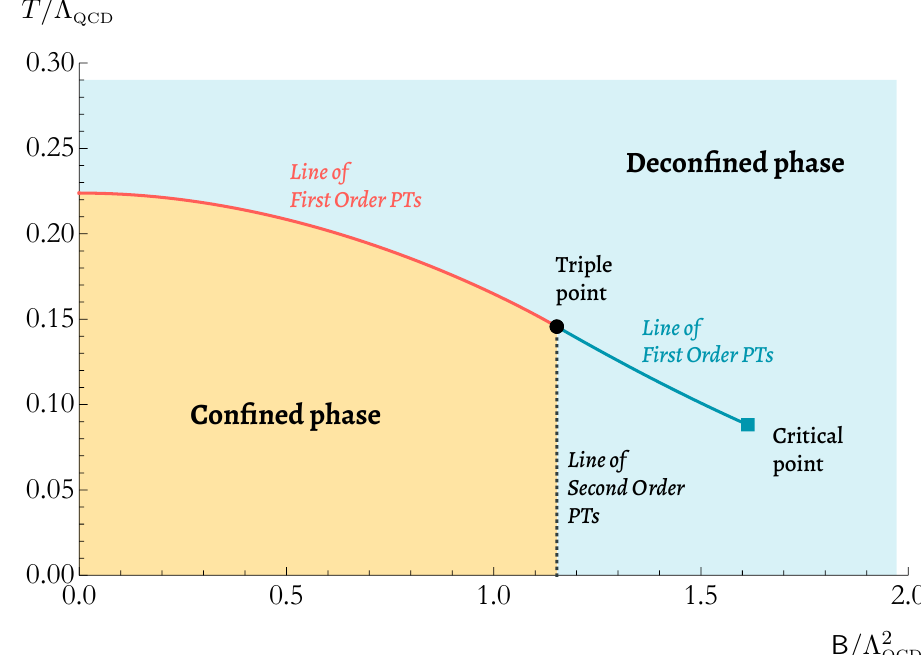
Figure 1. Phase diagram in the temperature, monopole magnetic field plane. The confined phase lies in the small temperature and magnetic field orange region, while the rest of the phase diagram corresponds to deconfined phases. The red, solid curve indicates a line of first order deconfinement phase transitions. The blue solid curve, however, stands for first order phase transitions between different deconfined phases. It ends at a critical point, represented by the blue square, where the phase transition becomes second order. Finally, the black, dotted line corresponds to second order deconfinement phase transitions. These three lines meet at a triple point, where coexistence of the three phases can